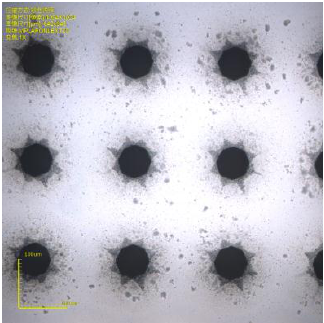
Figure 3. Picture of via holes with a 200 μm pitch distance.